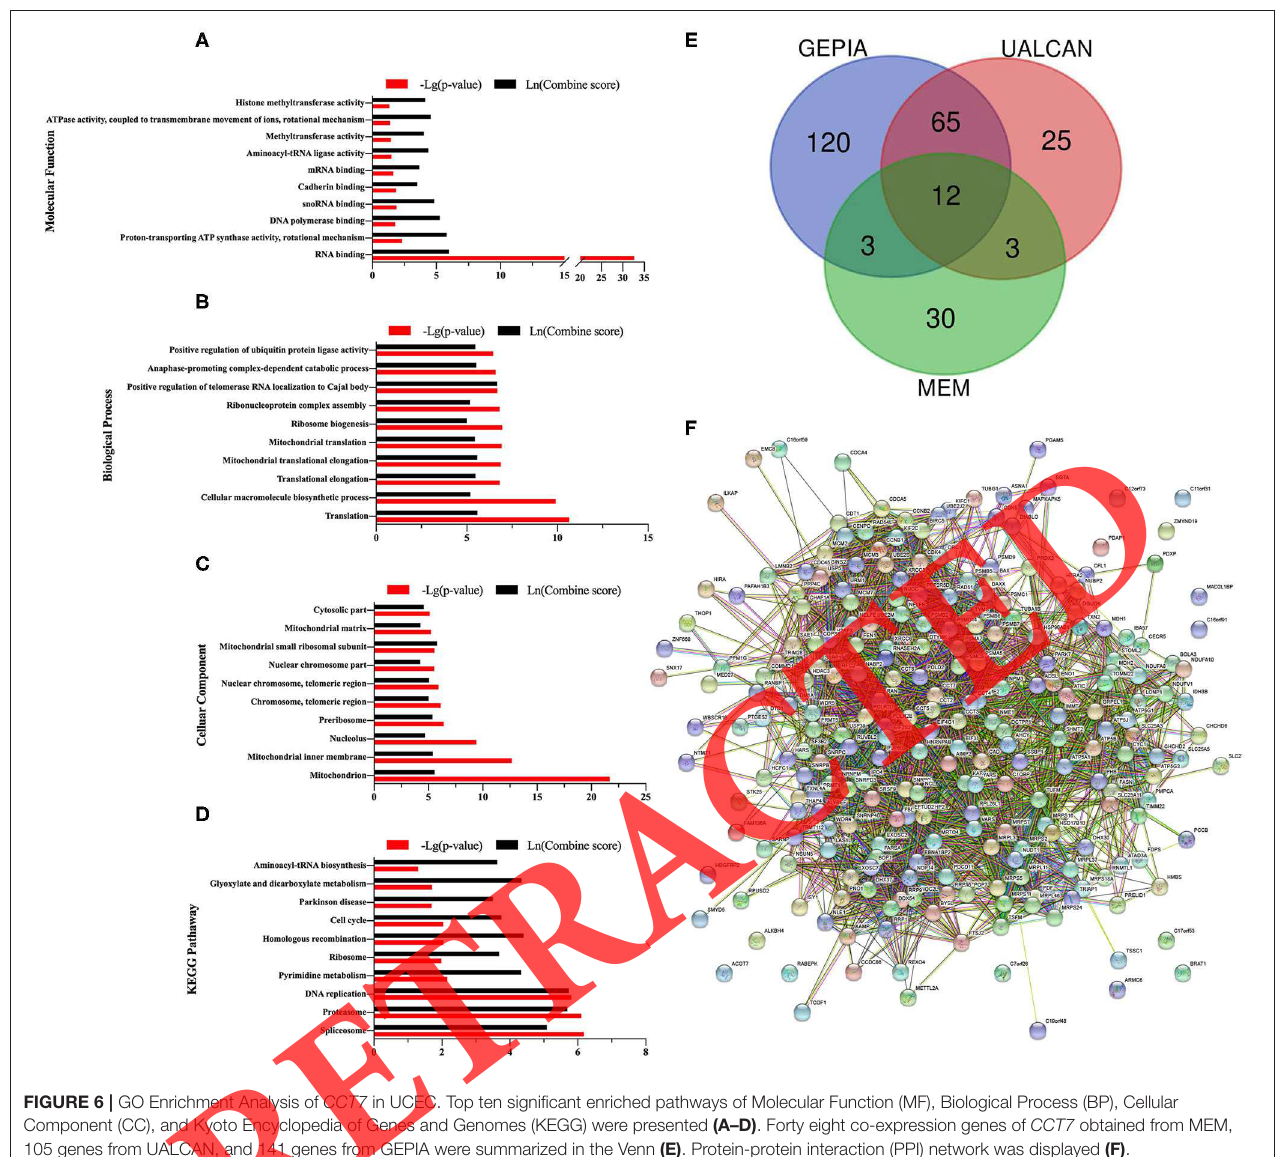
FIGURE 6 | GO Enrichment Analysis of CCT7 in UCEC. Top ten significant enriched pathways of Molecular Function (MF), Biological Process (BP), Cellular Component (CC), and Kyoto Encyclopedia of Genes and Genomes (KEGG) were presented (A–D) . Forty eight co-expression genes of CCT7 obtained from MEM, 105 genes from UALCAN, and 141 genes from GEPIA were summarized in the Venn (E) . Protein-protein interaction (PPI) network was displayed (F)